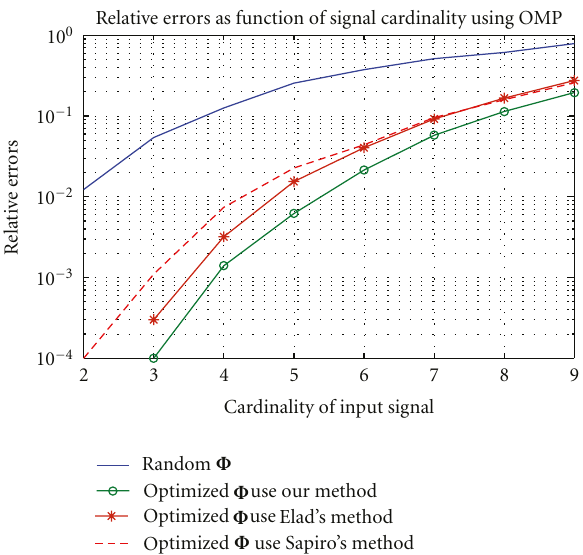
Figure 4: CS relative errors as function of signal cardinality using OMP.